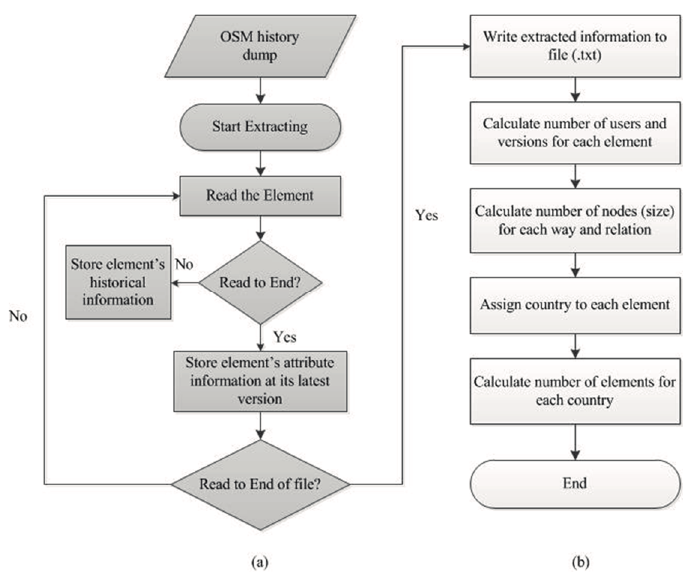
Figure 1. Flow chart for the data processing to extract essential information for